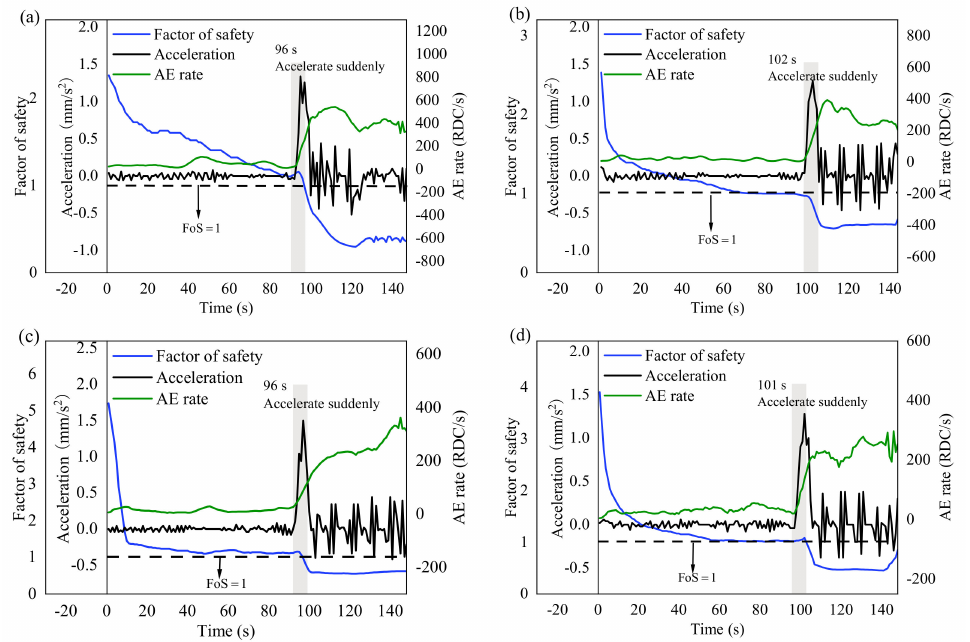
Figure 14. Acceleration, factor of safety (FoS), and ring down count (RDC) plotted against time in ( a – d ) for the four experiments. All data points are the moving average value of 5